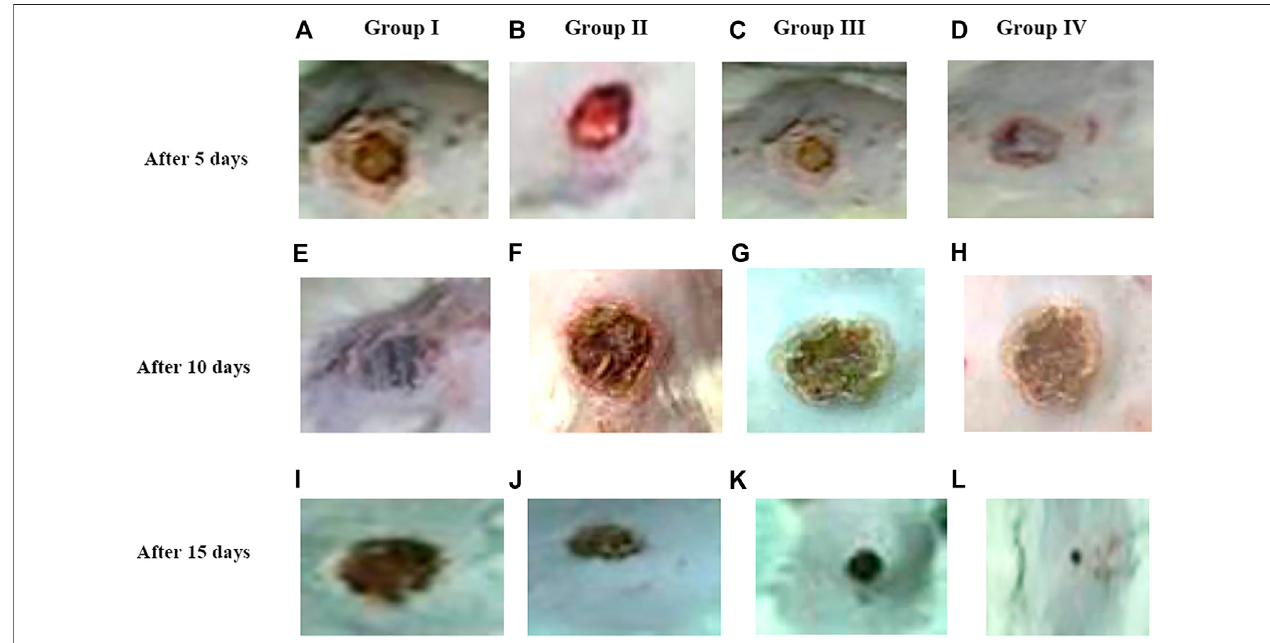
FIGURE 13 | Morphology of wound healing after exposure with ZnO nanorods (ZnO-NRs), phenytoin compared with control (non-treated). (A) Negative control (non-treated)after5 days. (B) Woundhealingafterexposurewith10 μ g/mlofZnOnanorods(ZnO-NRs)after5 days. (C) Woundhealingafter exposurewith20 μ g/mlof ZnOnanorods(ZnO-NRs)after5 days. (D) Woundhealingafterexposurewithphenytoinaspositivecontrolafter5 days. (E) Negativecontrol(non-treated)after10 days. (F) Wound healing after exposure with 10 μ g/ml of ZnO nanorods (ZnO-NRs) after 10 days. (G) Wound healing after exposure with 20 μ g/ml of ZnO nanorods (ZnO-NRs) after 10 days. (H) Wound healing after exposure with phenytoin as positive control after 10 days. (I) Negative control (non-treated) after 15 days. (J) Wound healing after exposure with 10 μ g/ml of ZnO nanorods (ZnO-NRs) after 15 days. (K) Wound healing after exposure with 20 μ g/ml of ZnO nanorods (ZnO-NRs) after 15 days. (L) Wound healing after exposure with phenytoin as positive control after 15 days